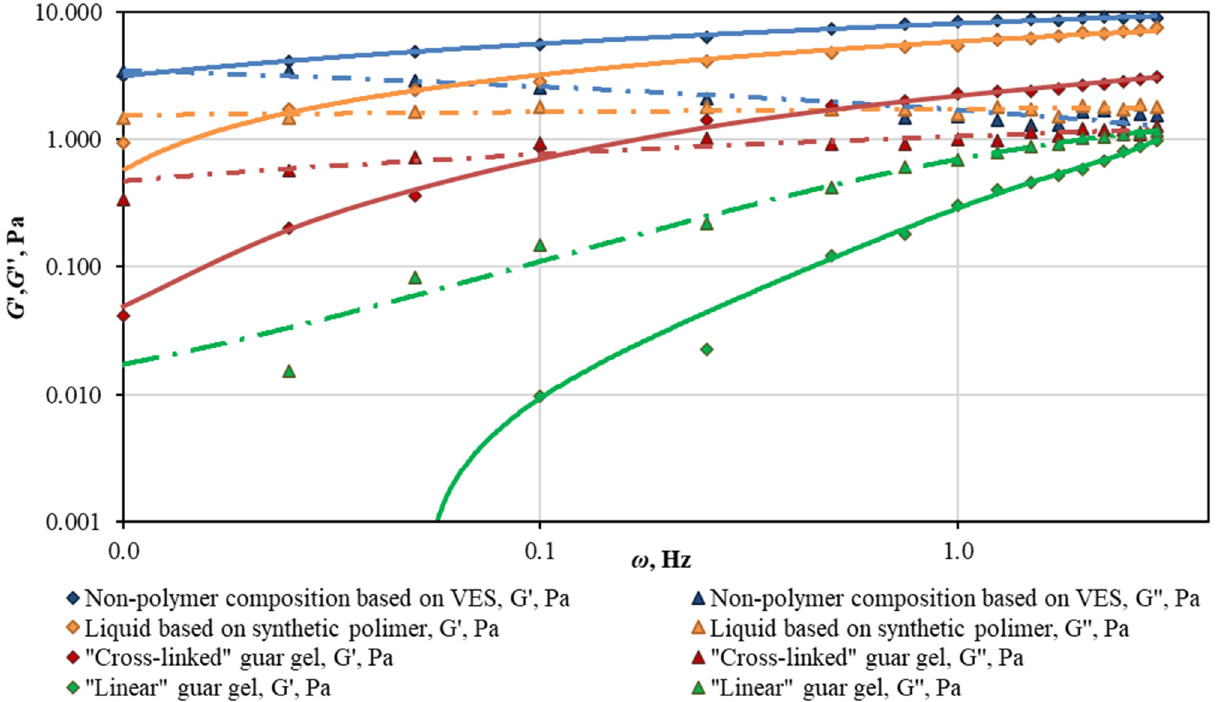
Figure 3. Frequency dependencies of G ′ and G ″ of various water-based fracturing fluids. As can be seen from the results in the “linear” guar gel the viscosity modulus prevails over the elastic modulus over the entire frequency range. Compositions based on “cross- linked” guar gel, VES, and synthetic polymers have different frequency dependencies for the elasticity and viscosity modulus. In the low-frequency region, the value of G ″ is higher than the value of G ′ and the compositions exhibit viscous fluid properties. However, in the high-frequency range the behavior of the curve’s changes and the value of G ′ increases and reaches a plateau while the values of G ′ for compositions based on VES and PHPA are significantly higher than for the “cross-linked” guar gel (at 2.0 Hz, the G ′ values are about 6.0 and 8.0 Pa for the compositions PolyGel and VES, respectively, while for the “cross-linked” gel the G ′ value is 2.7 Pa). At the same time, with increasing frequency the value of viscosity parameter G ″ is significantly reduced. For the composition based on VES, relatively low viscosity values and high elasticity values in comparison with the “crosslinked” gel can be explained by the formation of a complex viscoelastic system of interwoven VES surfactant micelles characterized by high elastic properties. The micellar surfactant system is formed due to weak non-covalent in- teractions; therefore, the deformation of the structure under mechanical influences is re- versible. For comparison, polymer systems can be irretrievably destroyed under the influ- ence of forces applied to them [76]. For systems based on a synthetic polymer, a possible explanation for similar dependencies is the formation of such structures due to hydrogen complex interactions between the amide groups of the polymer. It should be noted that the frequency dependencies of G ′ and G ″ of all the systems under study, except for the “linear” guar gel, can be considered from the point of view of the Maxwellian behavior of viscoelastic bodies. At a certain frequency, the graph shows the intersection of the curves of the elastic G ′ modulus and the viscosity G ″ modulus. The intersection point corresponds to the recip- rocal of the relaxation time and can be used to judge the structural properties of viscoe- lastic systems. The relaxation time increasing indicates a complex spatial structure. In the “cross-linked” guar gel—composed of PolyGel and VES—there is a shift of the point of